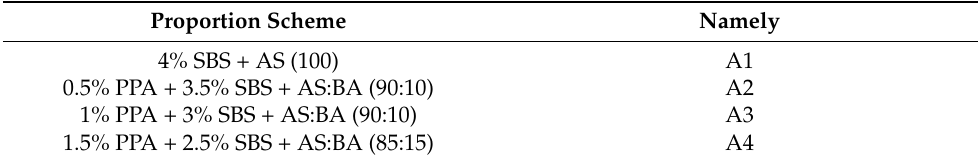
Table 3. The proportion of Bio-asphalt/PPA/SBS-modified asphalt. Proportion